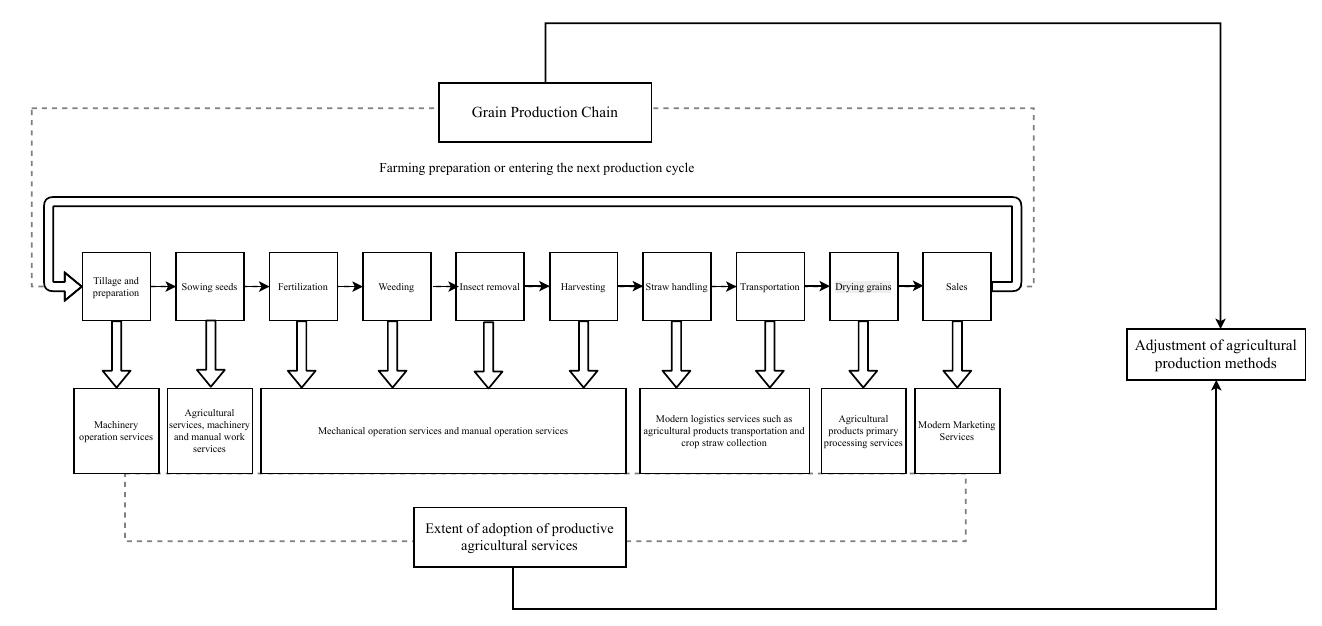
Figure 1. Theoretical